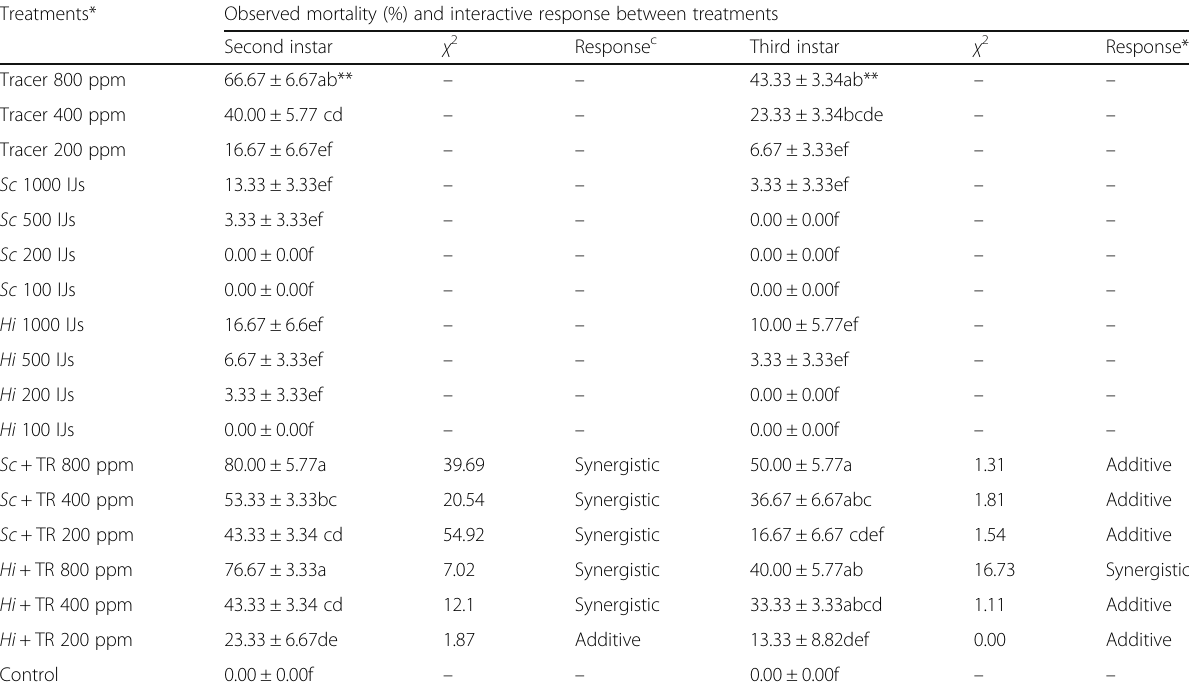
Table 3 Interaction between Tracer and entomopathogenic nematode species over mortality rate (mean ± SE) of the second and third larval instars of Spodoptera litura after 48 h of treatment application Treatments* Observed mortality (%) and interactive response between treatments Second instar χ